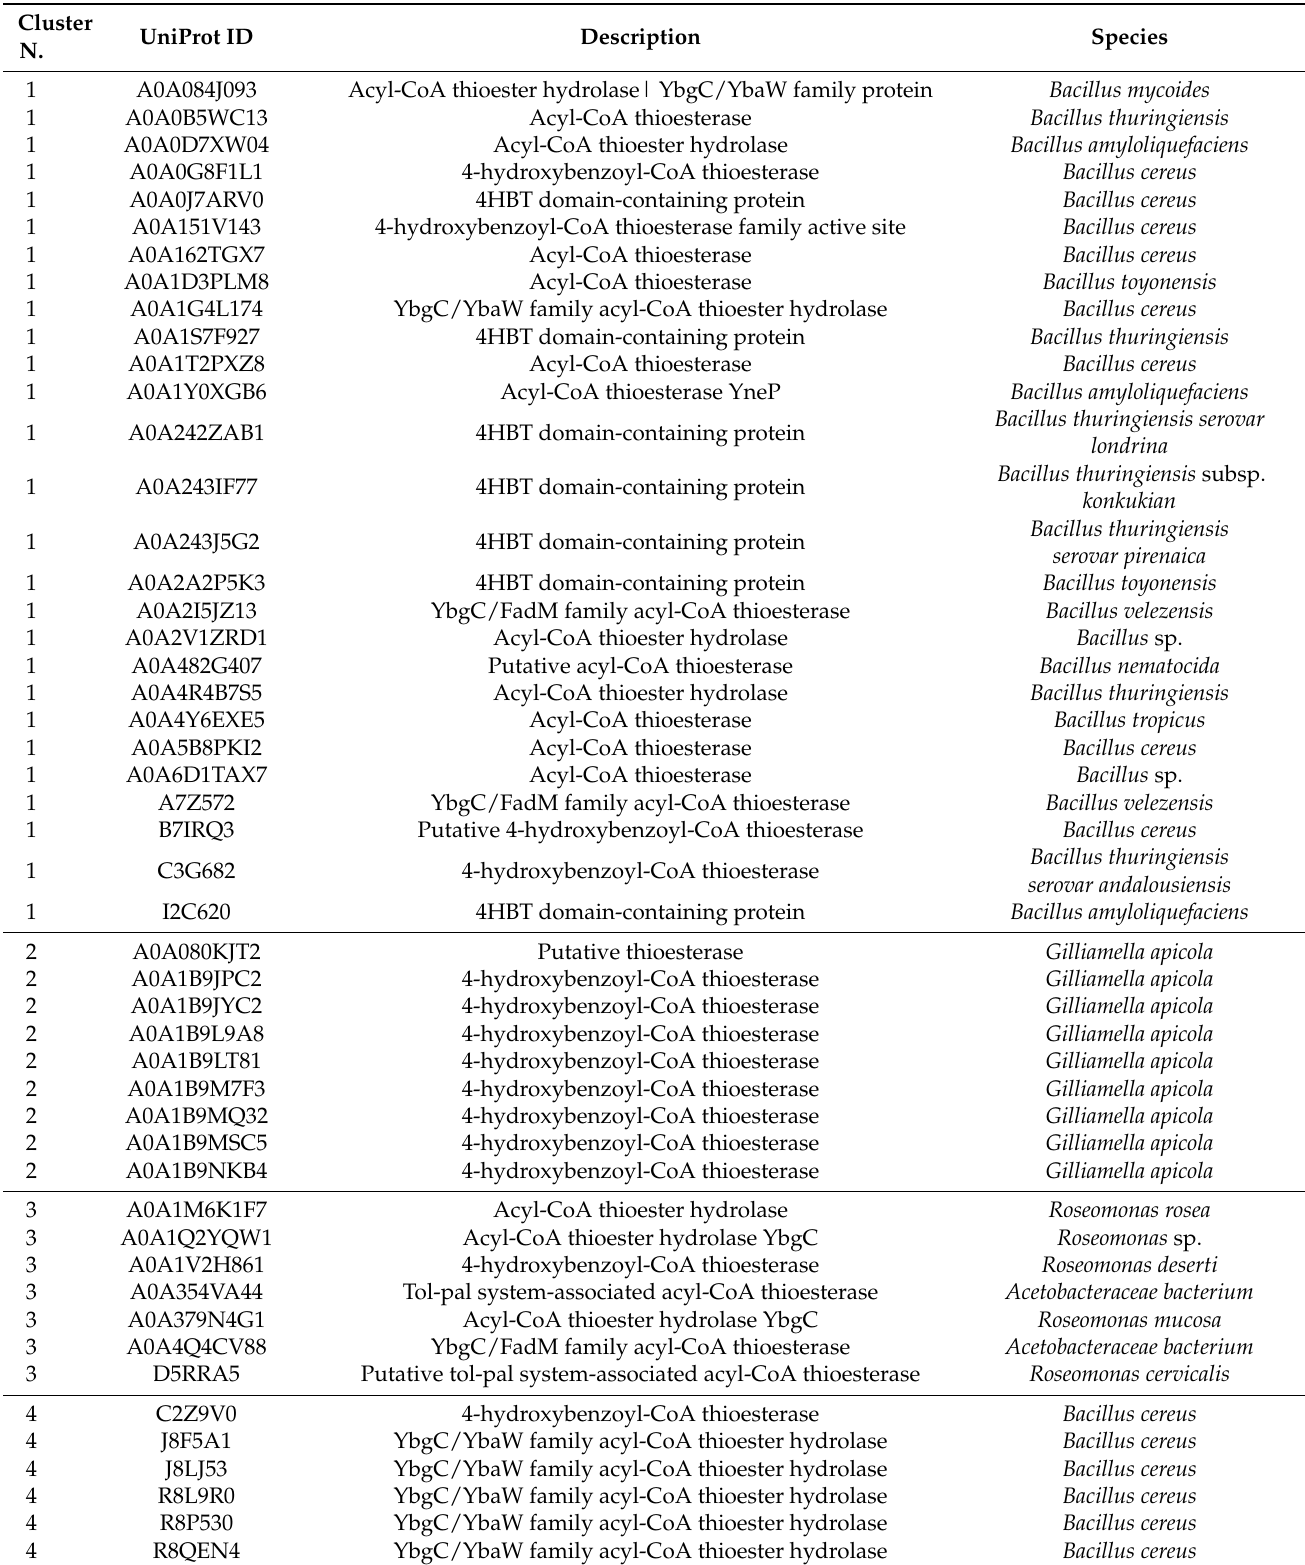
Table 2. List of potential methylketone homologs and their distribution in clusters, as calculated by the Sequence Similarity Network